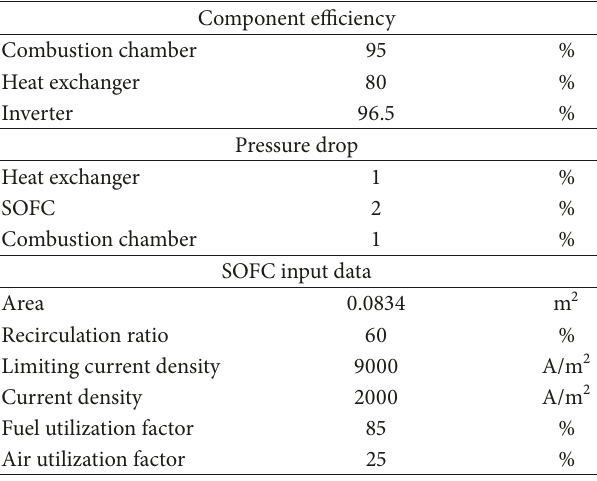
Figure 9: Variation of IRSOFC efficiency versus current density (first scenario). Table 5: Input parameters for IRSOFC system.